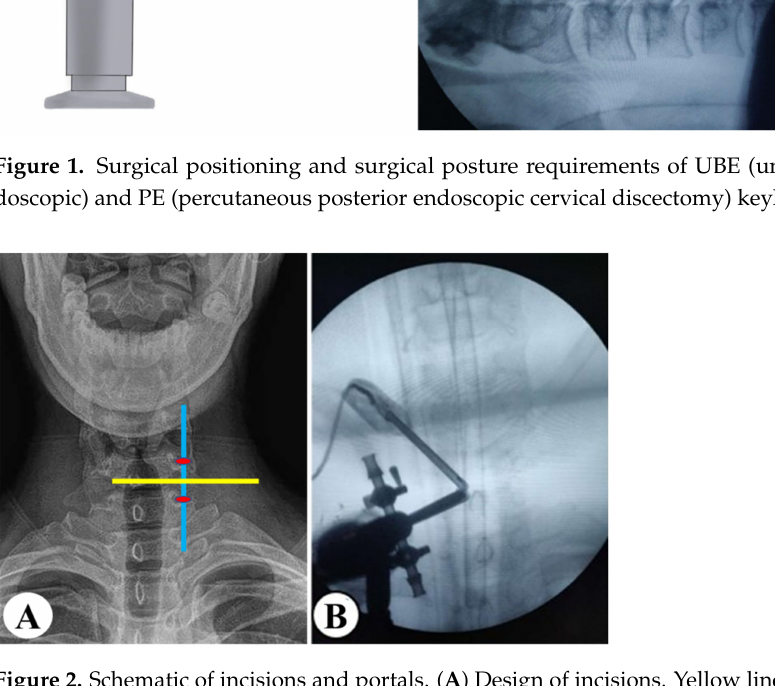
Figure 2. Schematic of incisions and portals. ( A ) Design of incisions. Yellow line: the horizontal line of the intervertebral space. Blue line: the midline of lateral mass. Red ovals: the viewing and working portals. ( B ) The endoscope and radiofrequency probe.